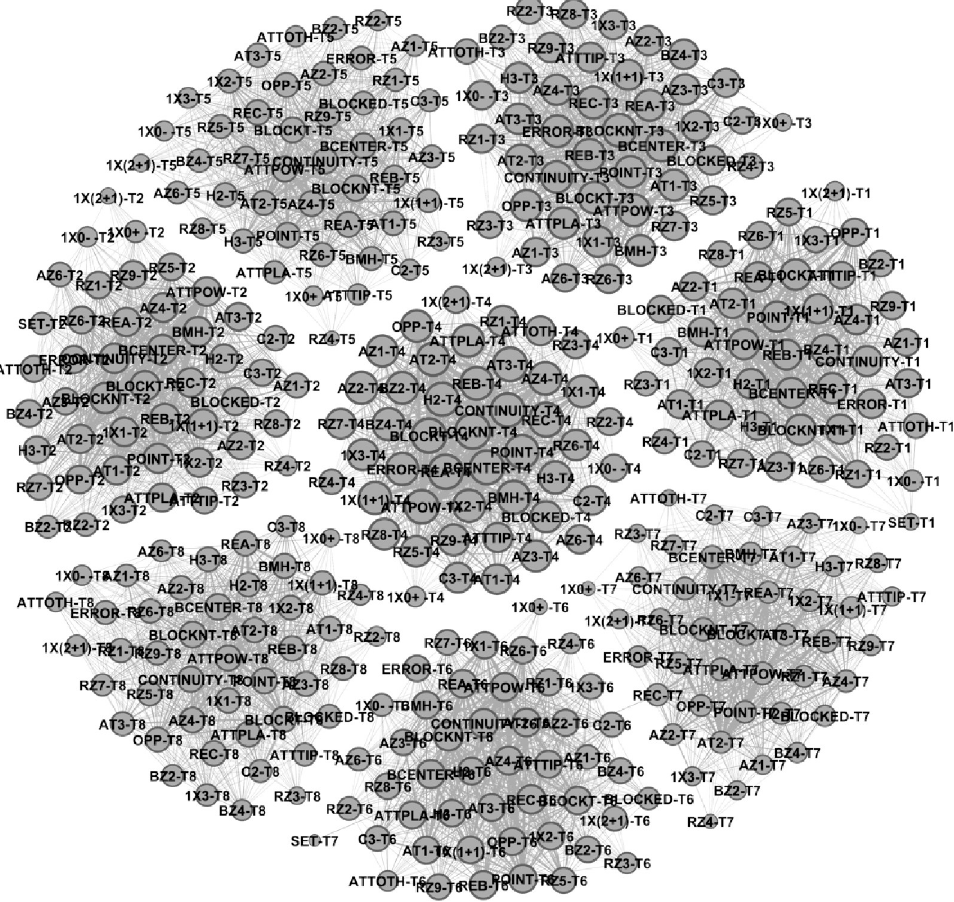
Fig 2. Global network with inter-team variability. Each team was represented with your classification number (1 means the first place or Team 1). Continuity (0.48–0.94) and Blocker in the Center (0.48–0.95). On the other hand, the variables